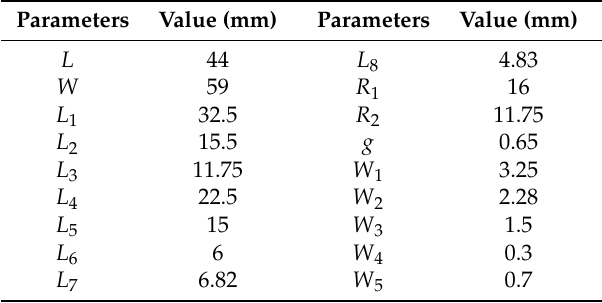
Table 1. Optimized tag antenna design parameters.